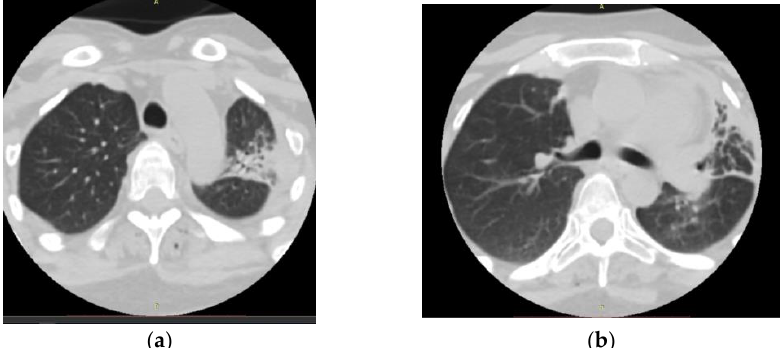
Figure 3. Chest computed tomography (CT) findings (February 2019): axial lung window setting showed atelectasis and a solid nodule surrounded by a halo of ground-glass attenuation in the left lung (superior segment and lingula), representing the “CT halo sign”. ( a ), axial section through trachea; ( b ), axial section below carina level.